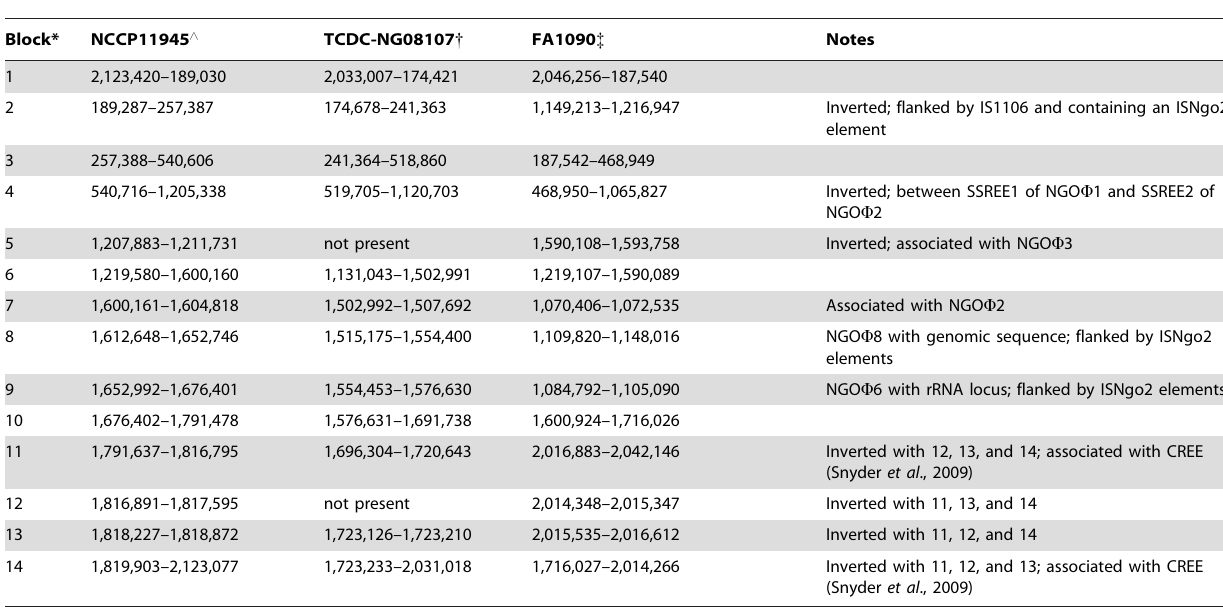
Table 1. Blocks of homologous sequence in N. gonorrhoeae genome sequences.